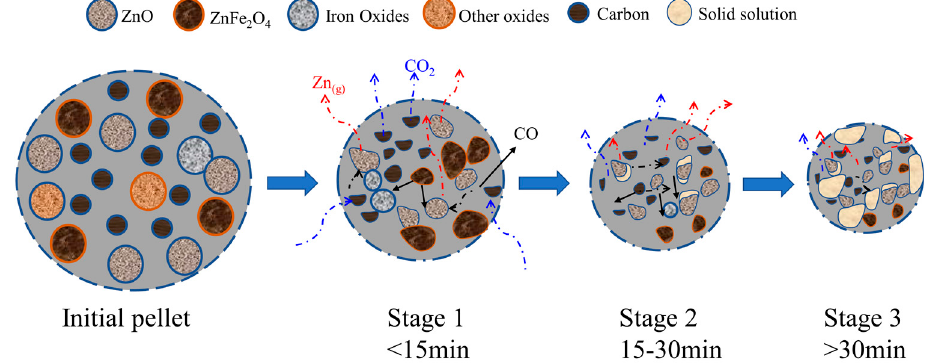
Figure 11. Schematic diagram of the mechanism of vacuum carbothermic reduction of EAFD.